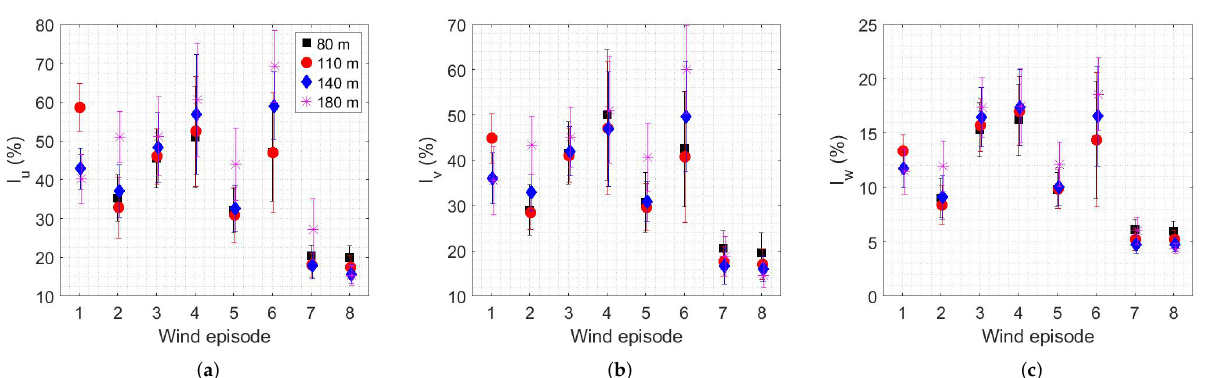
Figure 8. Mean turbulence intensity values in the along-wind ( a ), lateral ( b ) and vertical direction ( c ), obtained from Doppler wind lidar measurements at four different heights above the ground, for all eight wind